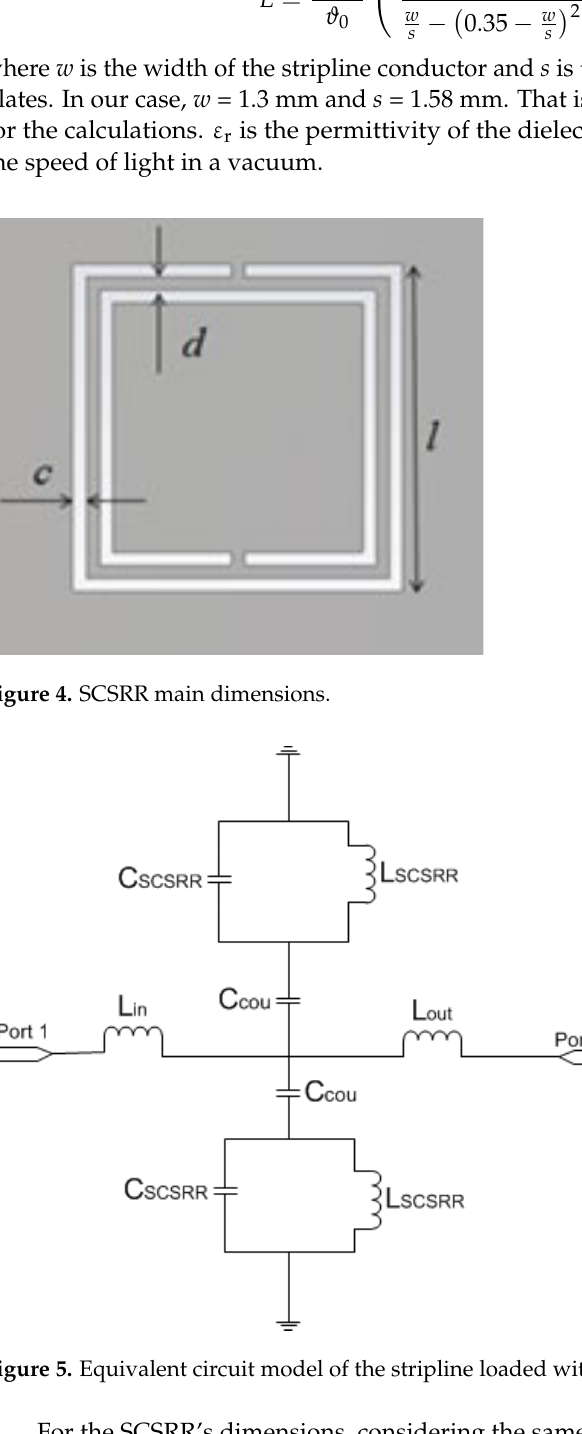
( b ) Vector values (front view).